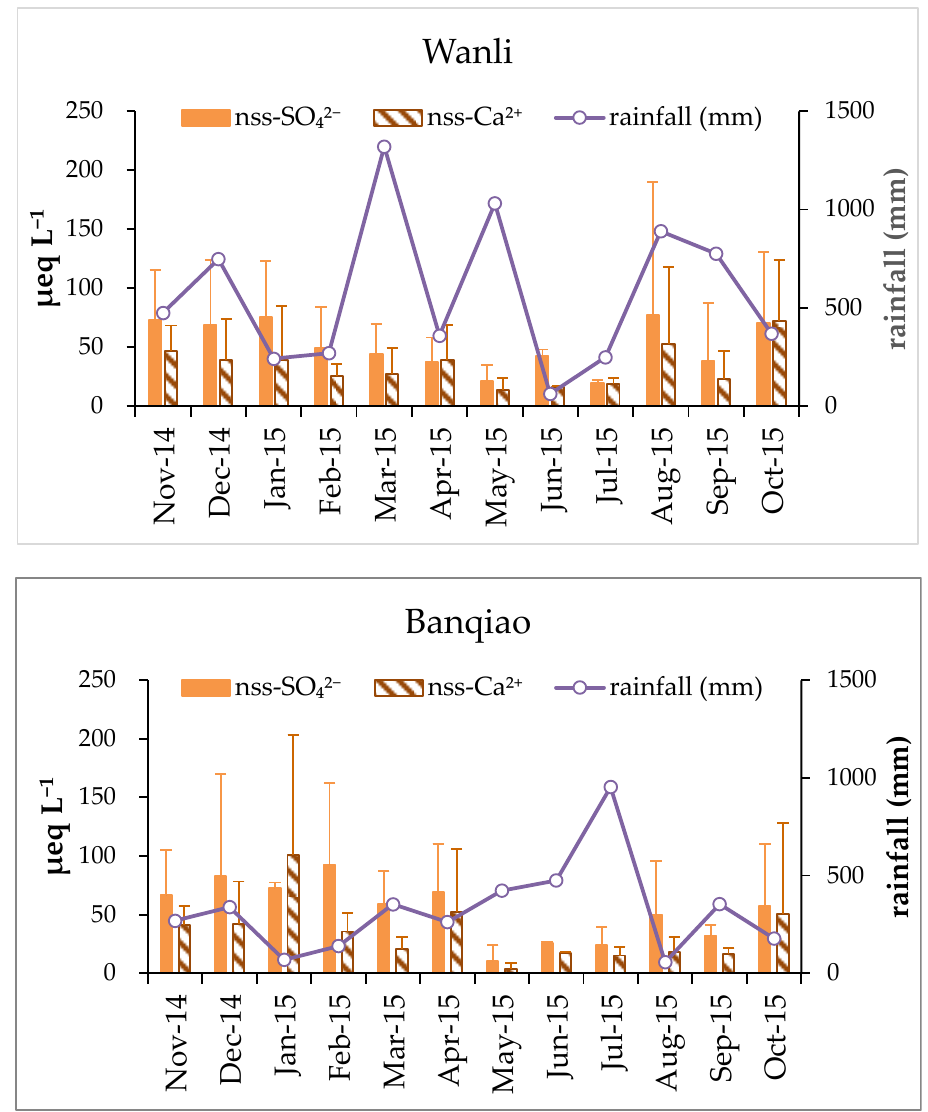
Figure 5. Variations in the monthly average concentrations of non-sea-salt ions at Wanli and Banqiao. (error bars represent the standard deviations for each month).